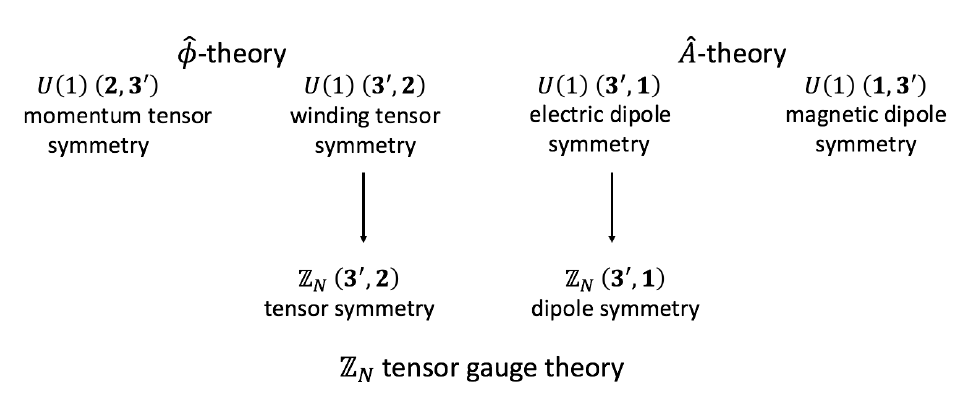
Figure 5: The global symmetries of the U ( 1 ) ˆ A -theory, the ˆ φ -theory, and the (cid:90) gauge theory and their relations. The momentum tensor symmetry of the ˆ φ -theory is gauged and therefore it is absent in the (cid:90) dipole symmetry of the ˆ A -theory is absent in the (cid:90) the constraint